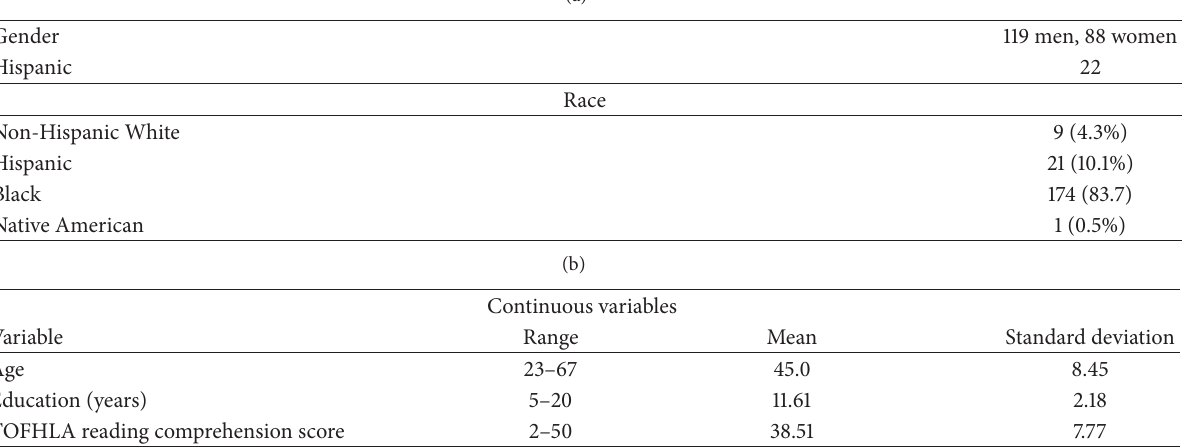
Table 1: Description of